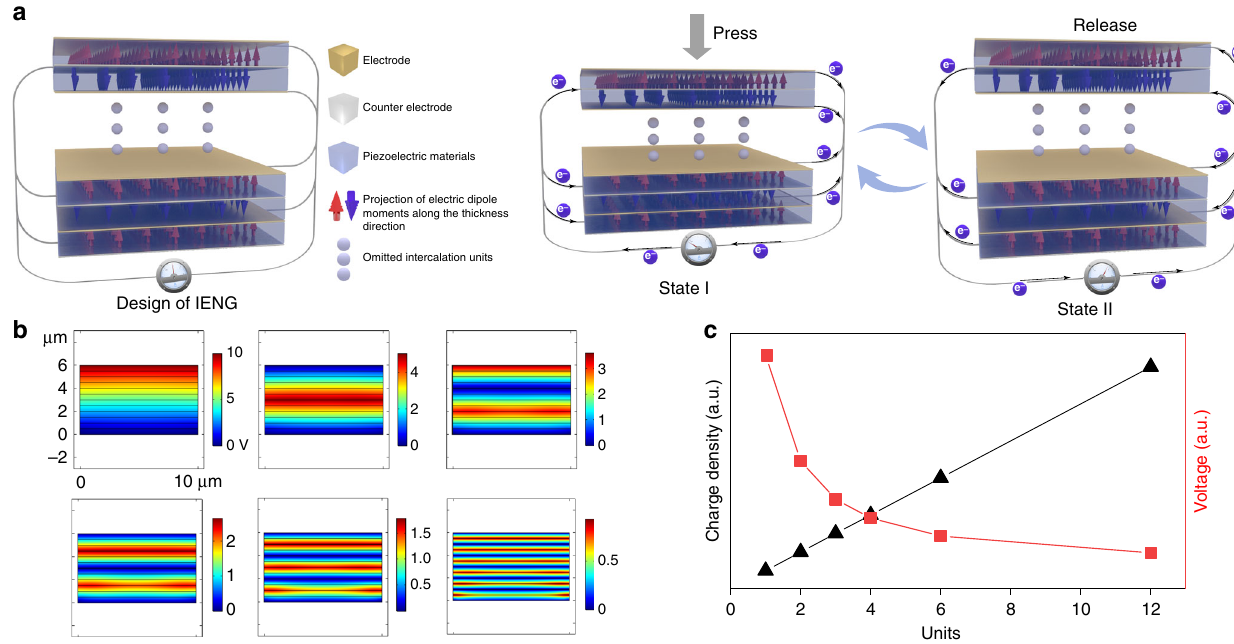
Fig. 2 Schematics and simulation results of the IENG. a Basic structure of the three-dimensional intercalation electrode. Each part of piezoelectric material is sandwiched by a pair of well-matched electrodes. The adjacent parts of piezoelectric material are polarized with opposite direction, and all the parts connected in parallel forming a three-dimensional device. The red and blue arrows represent the projection of electric dipole moment along the thickness direction. When driven by an external force, each unit in the IENG simultaneously generates small current in the same direction, then adding up to be a large output current through the three-dimensional intercalation electrode. b Distribution of piezoelectric potential in different units when the same piezoelectric layer model is divided into 1, 2, 3, 4, 6 and 12 units by different pairs of intercalation electrode. c The corresponding output charge density in short-circuit condition and output voltage in open-circuit condition generated by different